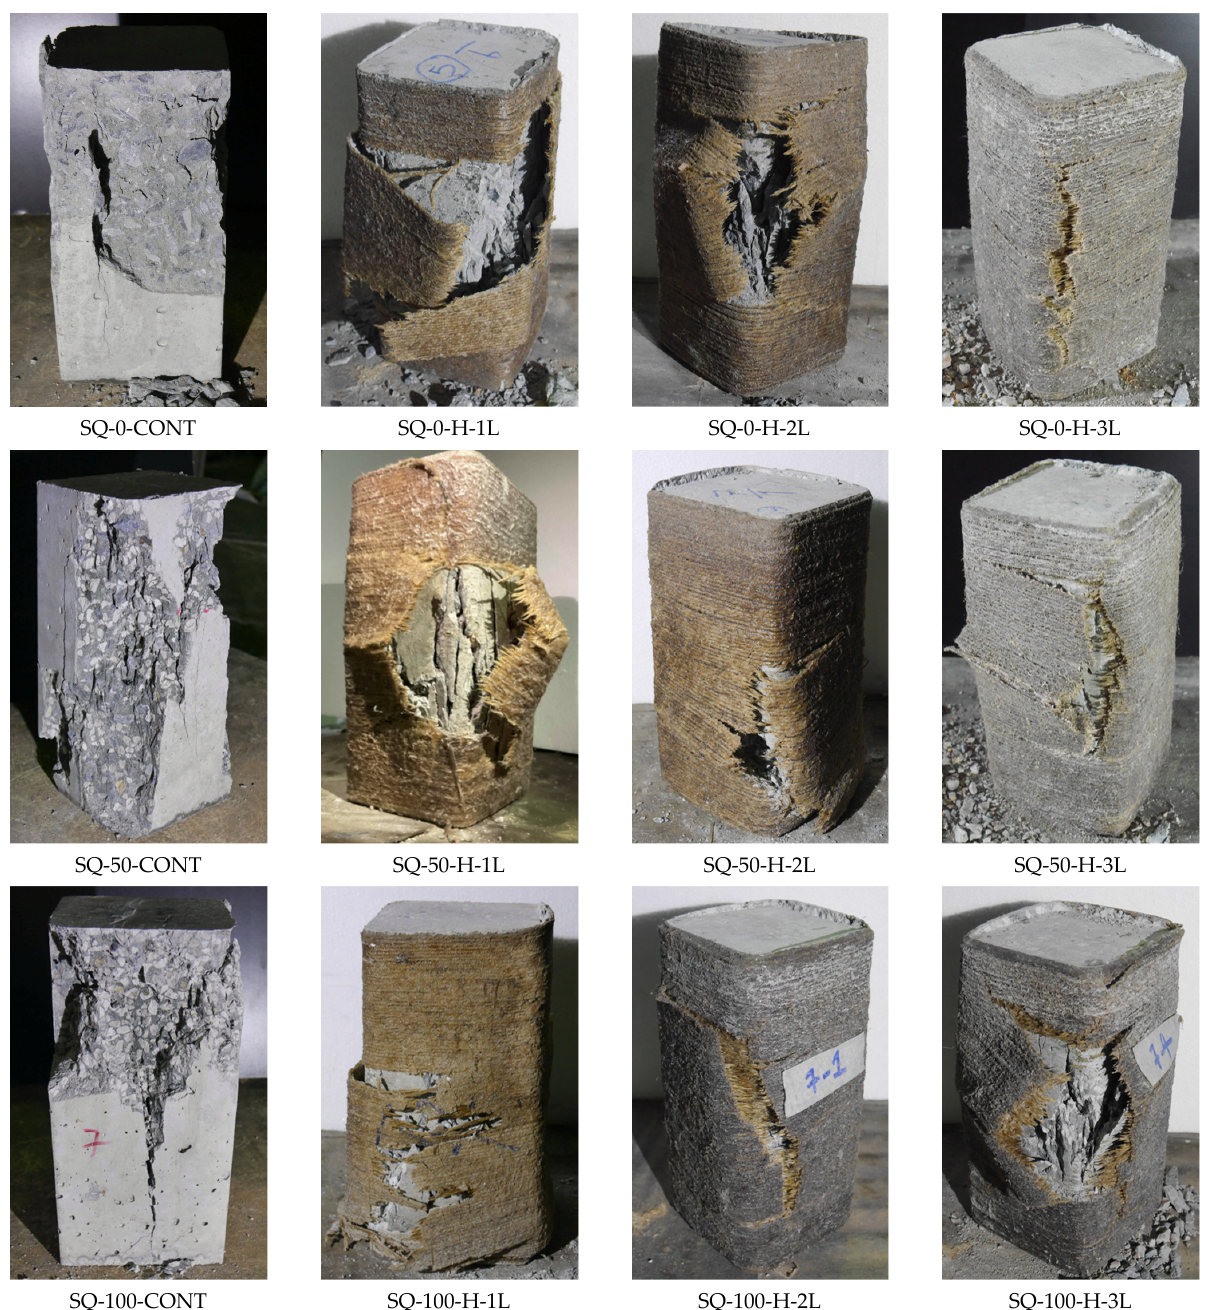
Figure 5. Ultimate failure modes of all